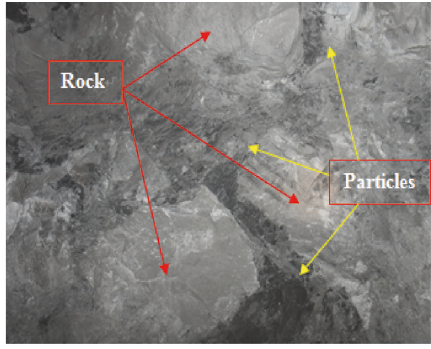
Figure 3: Rock and infilling material (particles) in a KCP.